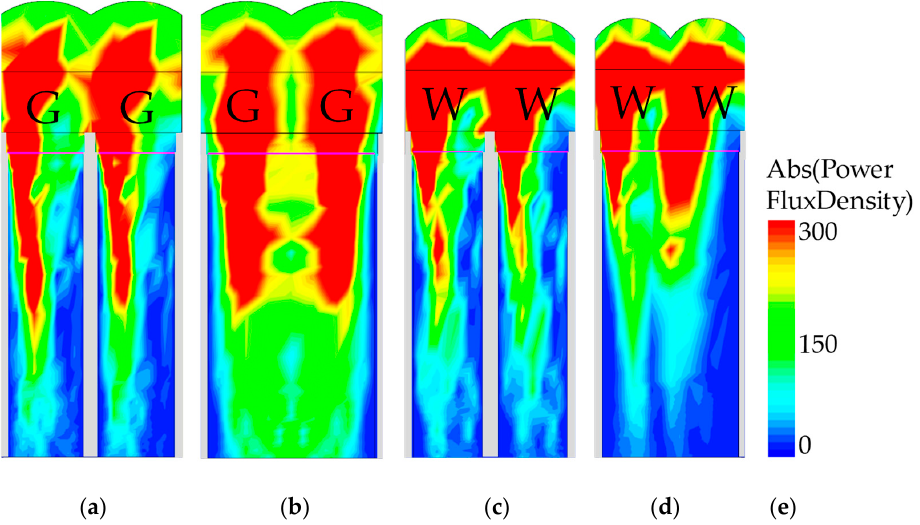
Figure 6. The beam profiles of the simulated power flux density. The incident light was a 540 nm wavelength at 20°: ( a ) the green pixels of the quad-Bayer CFA with DTI/WG in a 0.9 μ m pixel, ( b ) the green pixels of the quad-Bayer CFA with S-DTI/S-WG in a 0.9 μ m pixel, ( c ) the white pixels of the quad-WRGB CFA with DTI/WG in a 0.8 μ m pixel, ( d ) the white pixels of the quad-WRGB CFA with S-DTI/S-WG in a 0.8 μ m pixel, (e) the scale bar of power flux density. The red region in the beam profile shows the most transmitted light, which could be absorbed in the photodiode.